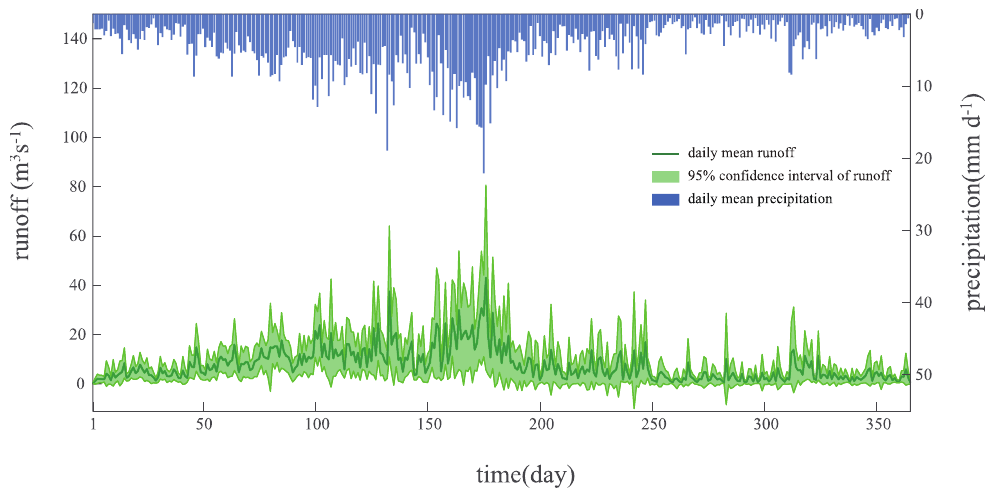
Figure 8. Daily mean GRS runoff over 31 years (1985-2015).